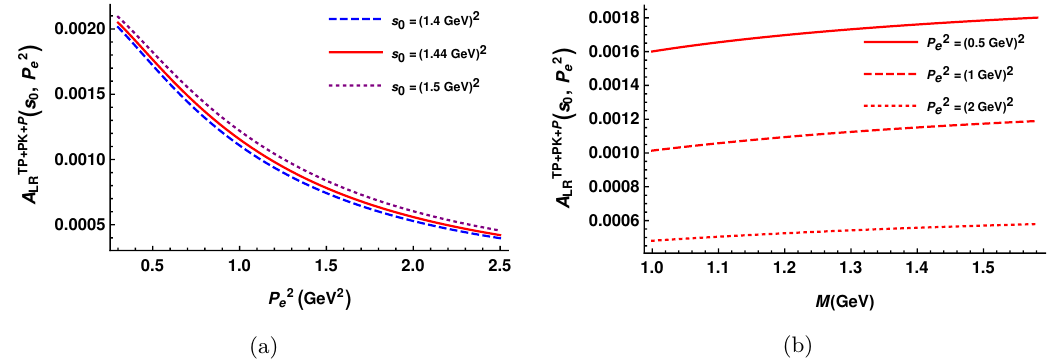
, F PK and F P . LR LR LR